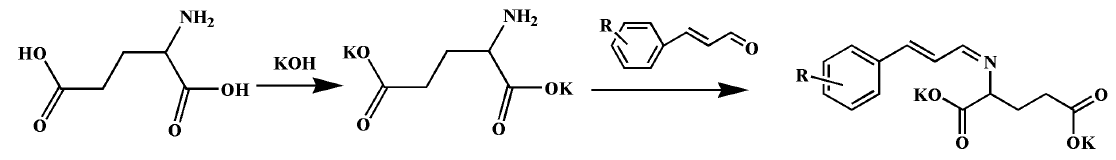
Figure 5. Synthesis routes of novel compounds.